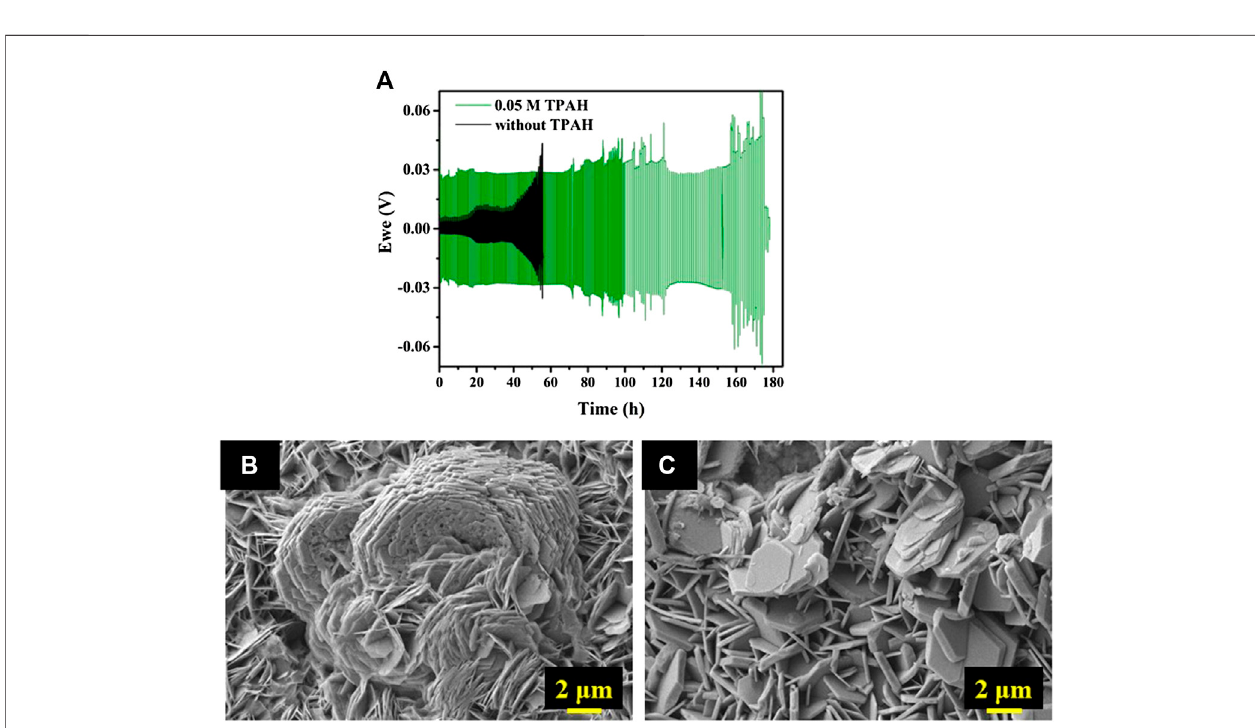
FIGURE 2 | (A) Voltage vs. time pro fi les of the Zn//ZnCl 2 + LiCl//Zn symmetric cells without and with 0.05 M TPAH electrolyte additive at a current density of 1 mA cm − 2 and SEM images of Zn electrodes after cycling (B) without TPAH (cycled 60 h), (C) with TPAH (cycled 180 h).